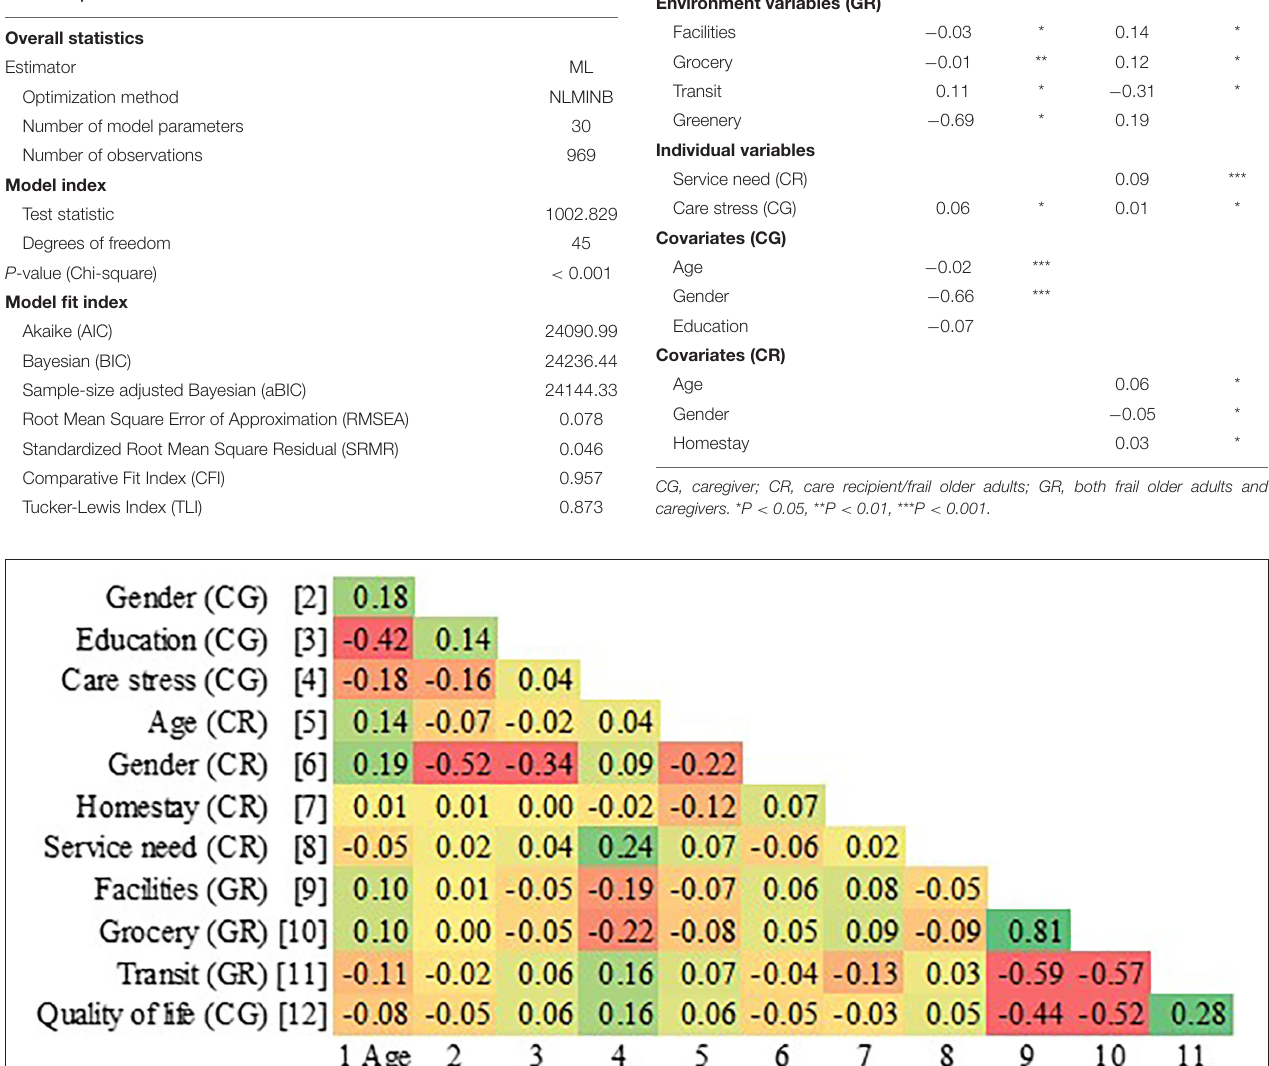
Frontiers in Public Health |